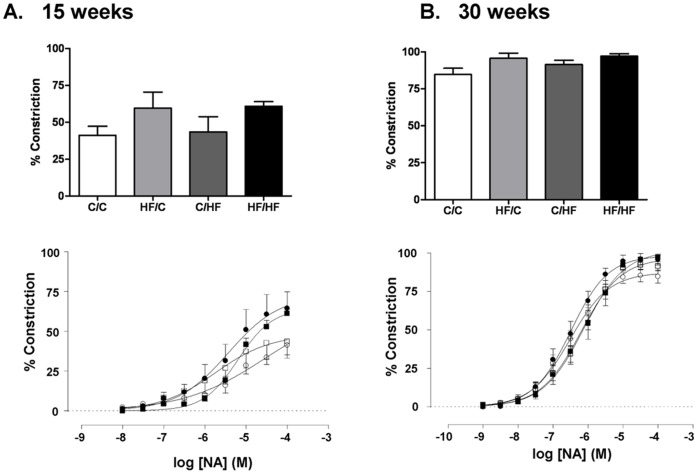
Impact of maternal HF-feeding on offspring vasoconstrictor responses in the femoral artery.Cumulative dose response curves and maximum response (%) to the vasoconstrictor noradrenaline (NA) measured in the femoral artery of male mice offspring from four dietary groups at (A) 15 weeks of age and (B) 30 weeks of age C/C (○) H/FC (•) C/HF (□) or HF/HF (▪). Data are mean ± SEM (n = 6 per group).